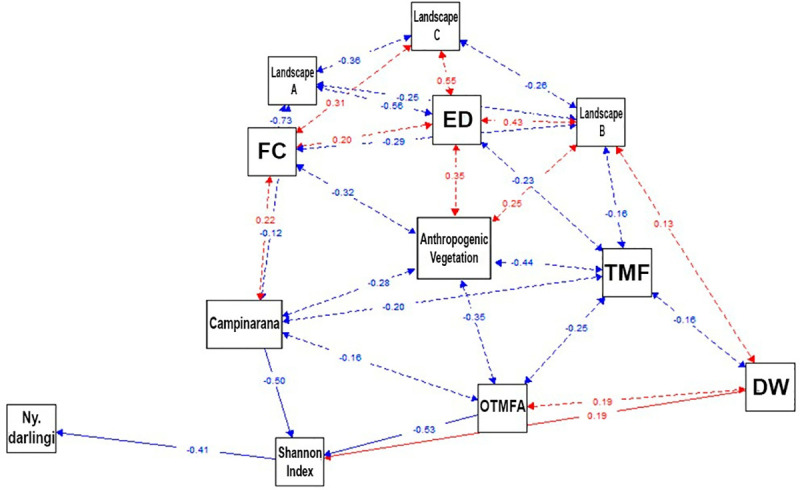
Structural equation model diagram to describes the relationships between changes in Ny. darlingi abundance with each independent variable: Shannon-index, PLAND, ED, landscape structure categories (A: PLAND ≤ 50% and ED < 0.015 m/ha; B: PLAND ≤ 50% and ED ≥ 0.015 m/ha; C: PLAND > 50% and ED ≥ 0.015 m/ha; D: PLAND > 50% and ED < 0.015 m/ha), Amazonian vegetation class (Atp: Anthropogenic; OTMF: Open Tropical Moist Forest; OTMFA: Open Tropical Moist Forest with Arecaceae dominance; TMF: Tropical Moist Forest; Cpn: Campinarana) and DW. Dashed lines represent a reciprocal path, and solid line one direction. Red arrows (positive coefficient) and blue arrows (negative coefficient) represent the significant path coefficients (P < 0.05).